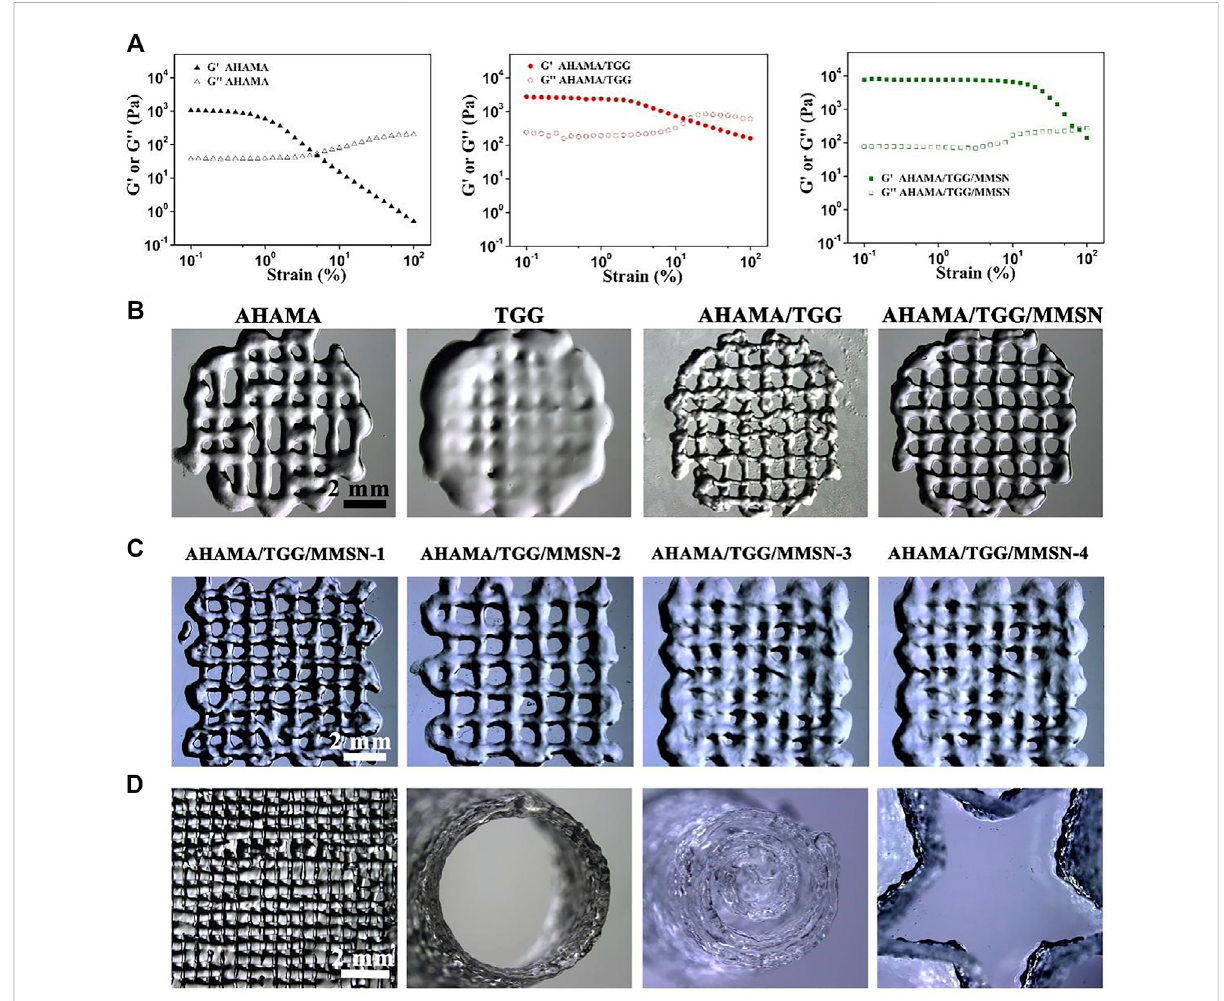
FIGURE 3 (A) Resultsofstrain-dependent(w=6.28 rad/s)oscillatoryshearofAHAMA,AHAMA/TGGandAHAMA/TGG/MMSNhydrogels. (B)